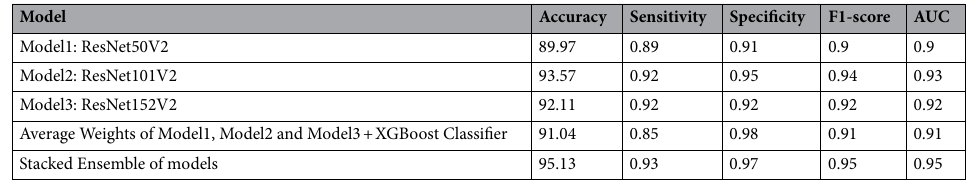
Table 6. Pathology classification results on the CBIS-DDSM dataset.